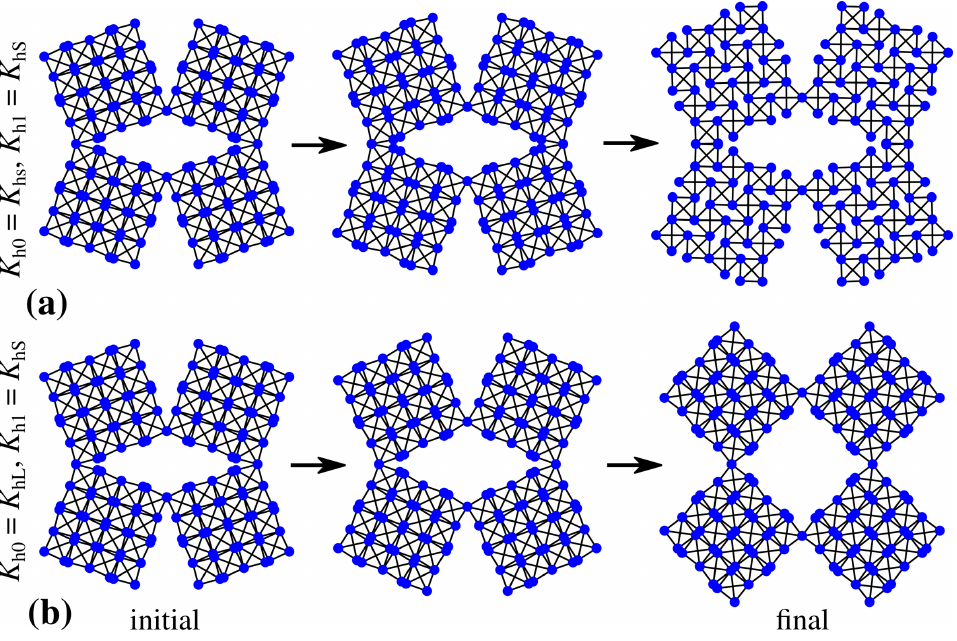
Figure 3. The panels show the evolution of the hierarchical system where: ( a ) K h 0 = K h 1 = K hS (all hinges are soft) and ( b ) K h 0 = K hL and K h 1 = K hS (level 0 hinges are stiff and level 1 hinges are soft).